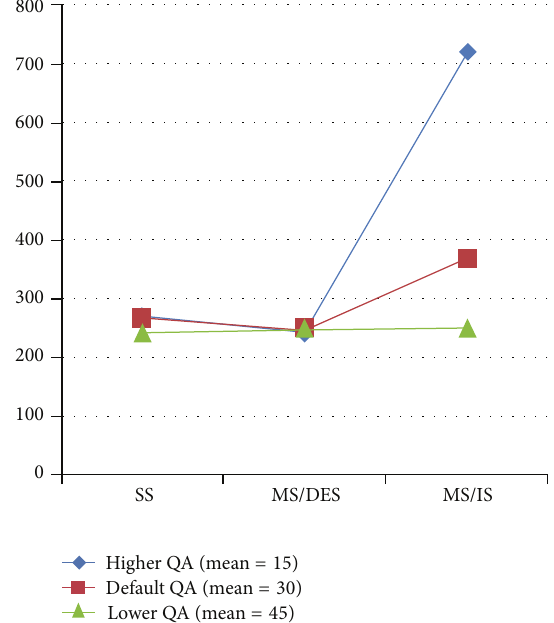
Figure 12: Results of Average Energy Consumption Per Submitted Query for different query